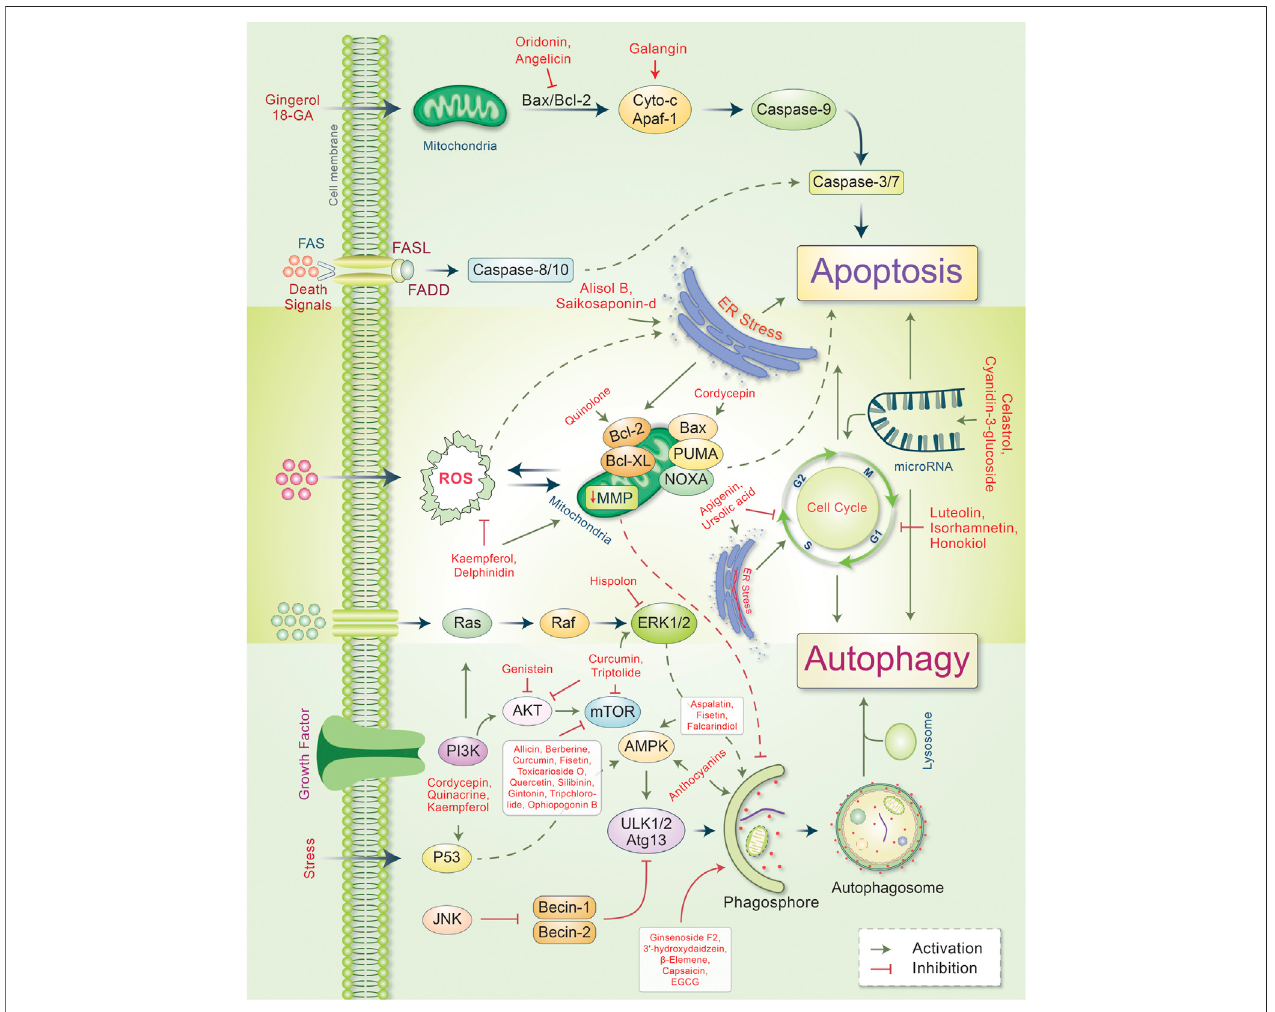
FIGURE3| Majorphytochemicalsinducethesignaltransductionpathwaysthatregulateautophagicandapoptoticcelldeathincancer.Phytochemicalshavebeen found to activate both the intrinsic and extrinsic apoptotic pathways by inducing a dysfunction in mitichrondria-caspase-9 and FAS-ligand-caspase-8 mediated apoptotic cell death, respectively. Phytochemicals induce ER stress and apoptotic cell death. However, some phytochemicals modulate mitichrondrial biogenesis and ensure apoptosis-autophagic cell death. Phytochemicals regulate the cell cycle and microRNA as well as cause apoptosis-autophagic cell death in cancer cells. Some phytochemicals activate autophagic signaling and inhibits cell growth and autophagy. For a detailed explanation, see the text.